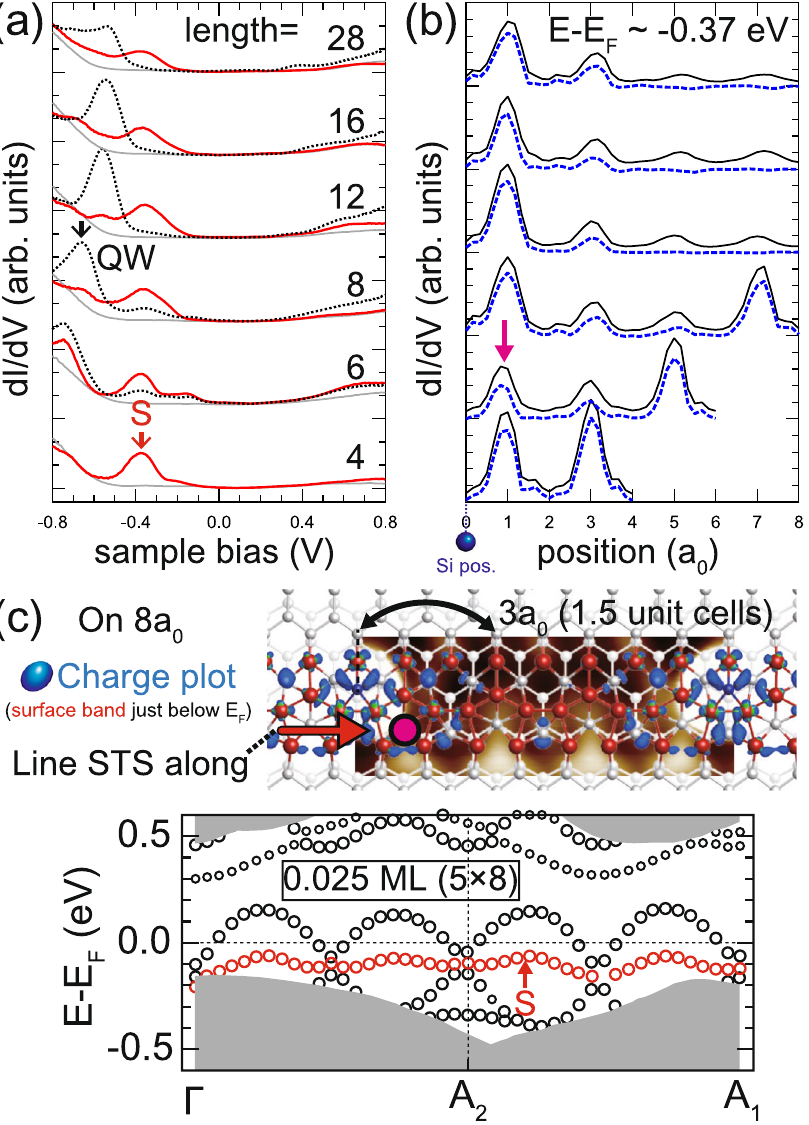
Figure 4. ( a ) dI / dV curves of 4 a 0 , 6 a 0 , 8 a 0 , 12 a 0 , 16 a 0 , and 28 a 0 wire segments. Red curves are recorded at positions 1 a 0 away from Si adatoms [magenta markers in ( b ) and ( c )] and vertical offsets are given for comparison. Gray and dotted line curves display reference data sampled on Si adatom and center of chain positions 22 , respectively. ( b ) dI / dV spatial profiles measured at a bias of − 0.37 V from the adatom center up to the 8 a 0 apart positions of the selected wire segments. Dashed profiles display the same profiles after subtracting the background × 2 modulation of the adatom-free part. ( c ) Charge plot and associated band structure of the surface with 0.025 monolayer adatoms (5 × 8) 26 . STM image of 8 a 0 segment is taken at bias voltage − 1 V. The charge density (blue area) calculated from the surface state band below Fermi level (red circles) is overlaid. The calculated band dispersion of the 5 × 8 structure are also given, where the smaller circles indicate less weights in the topmost